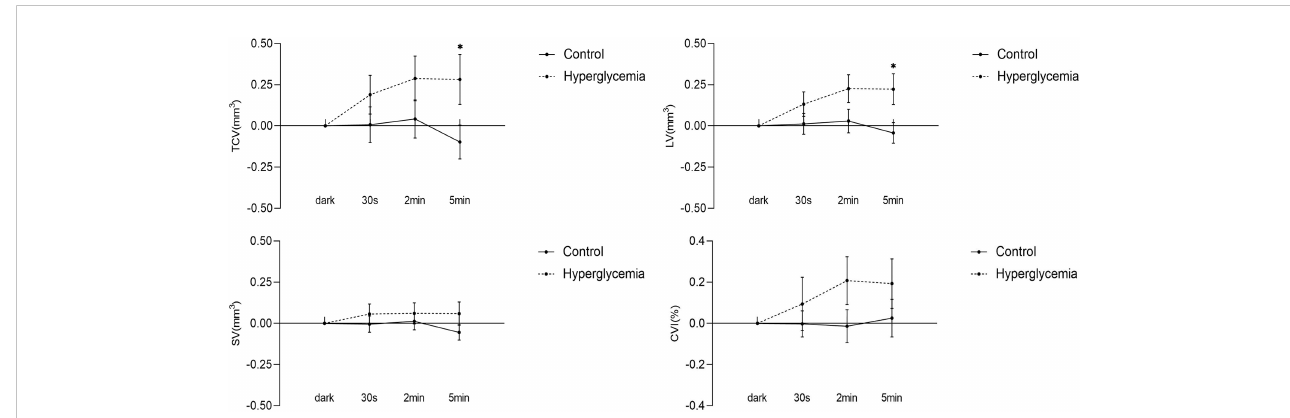
FIGURE 4 Difference in choroidal parameters between the glucose condition and control during light adaption. Asterisks represent a signi fi cant difference between hyperglycemia and control (P < 0.05). CVI, choroidal vascular index; SV, stromal volume; TCV, total choroidal volume; LV, luminal